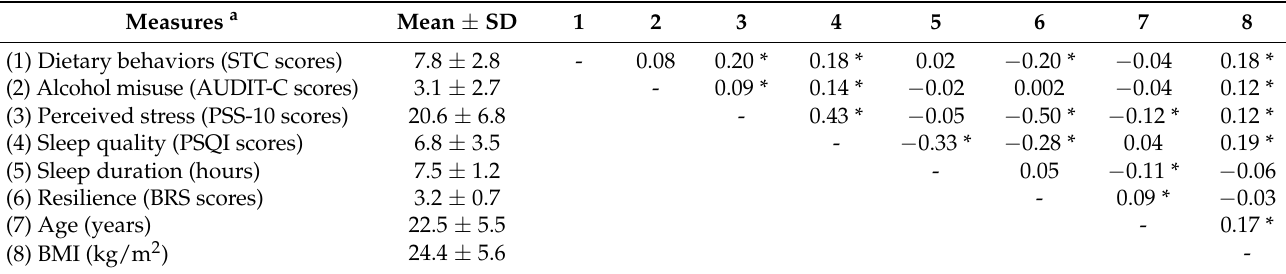
Table 3. Zero-order correlations between constructs tested and